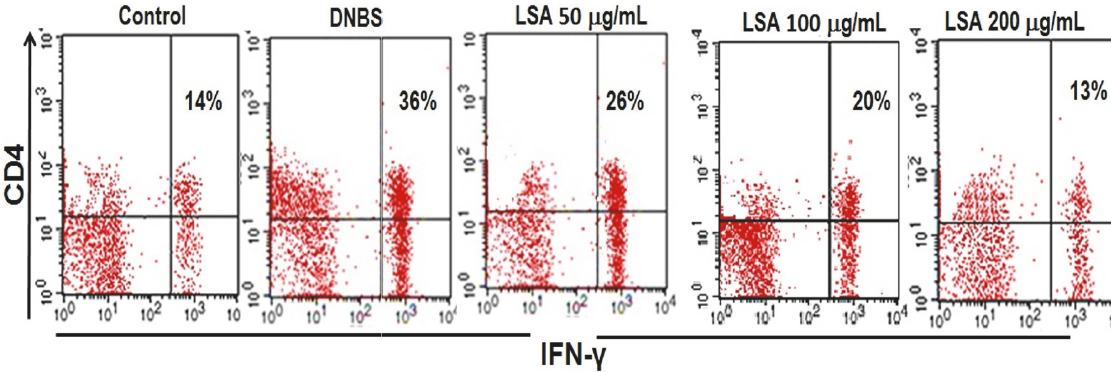
Figure 4: Effect of LSA on suppressing the development of colitis via percentage of IFN- 𝛾 . A: percentages of lymphocytes T CD4 + IFN- 𝛾 +